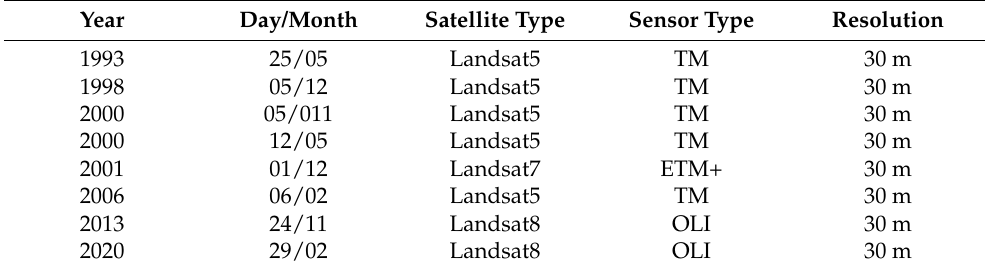
Table 1. Remote Sensing Image Satellite Type